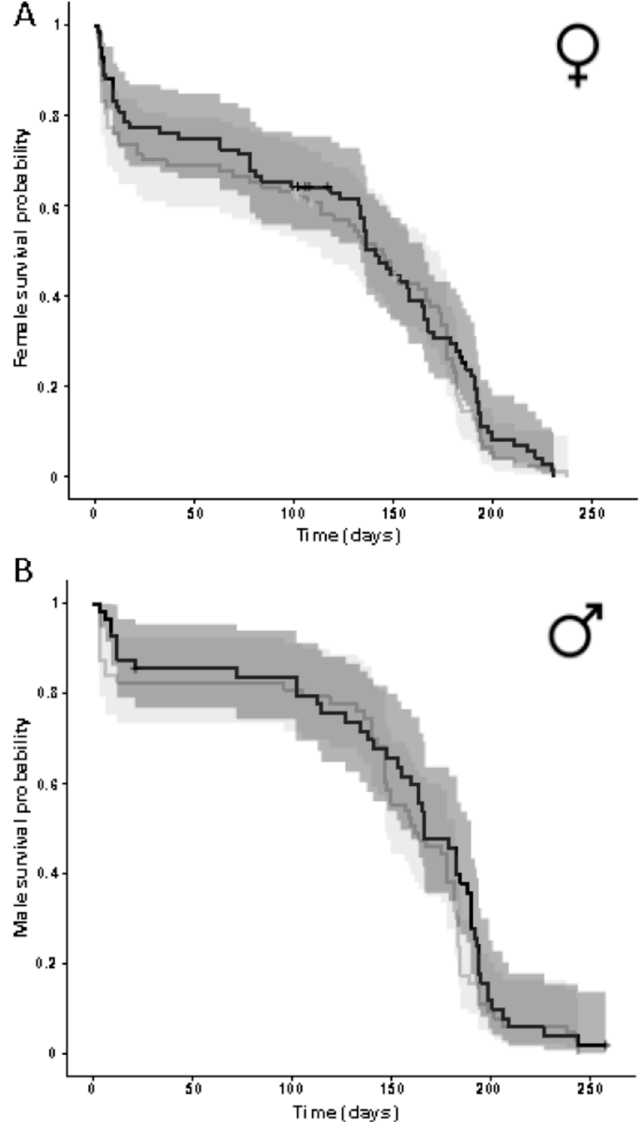
Figure 3. Survival of ( A ) female and ( B ) male adult O. surinamensis beetles with (black lines and dark grey shaded areas) and without (grey lines and light grey shaded areas) symbionts from the JKI-2 experimental lines. ‘+’ signs indicate censored individuals that were lost during the experiment. Shaded areas indicate 95% confidence intervals. No significant differences between symbiotic and aposymbiotic beetles were observed for neither females nor males (Cox regression, p > 0.05).